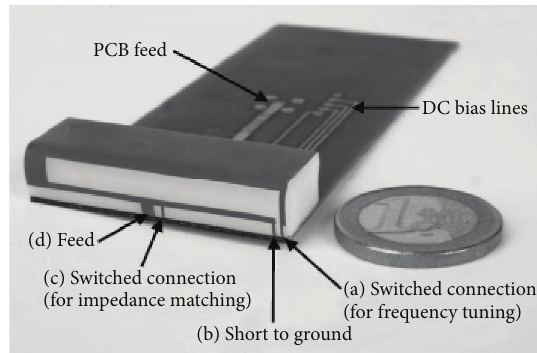
Figure 2: Frequency switchable PIFA antenna with MEMS [4].